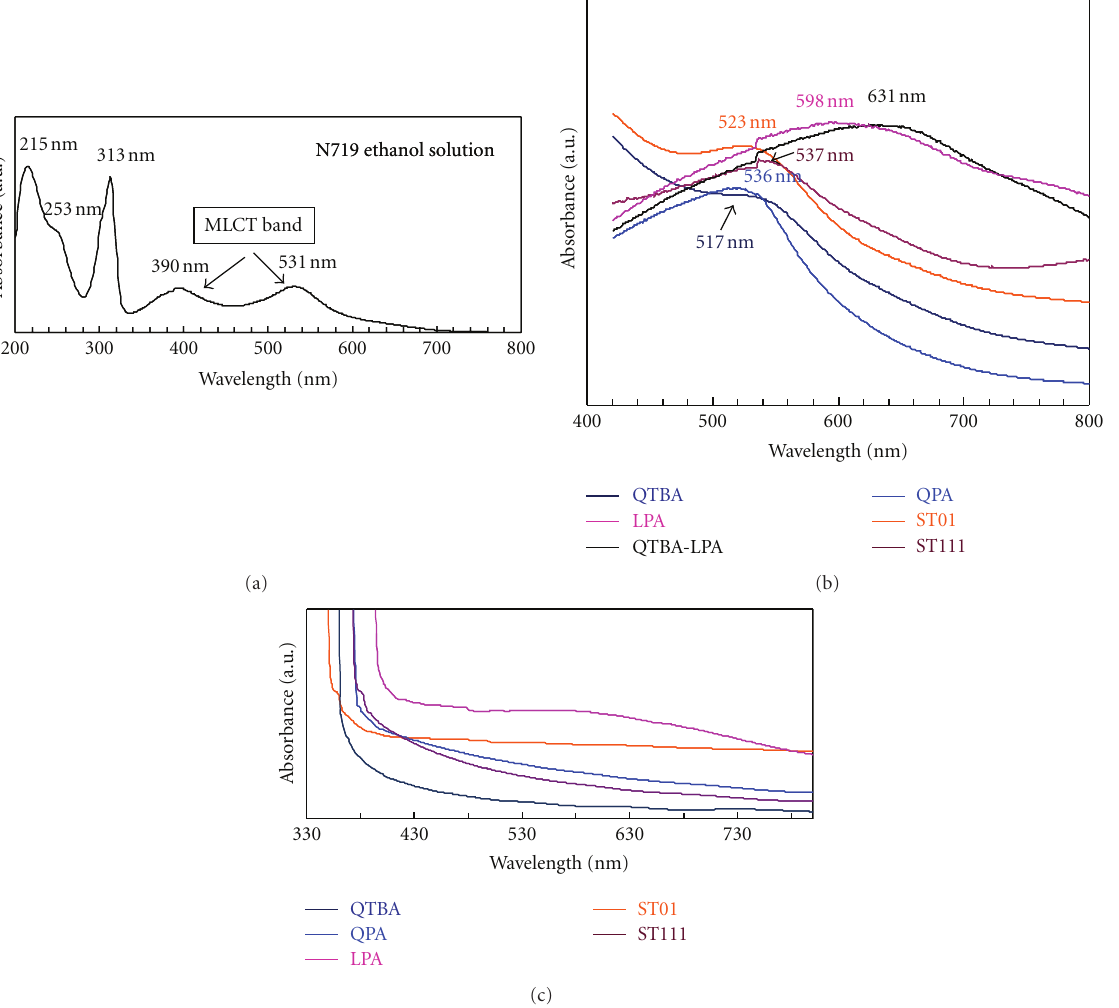
Figure 4: Absorption spectra of N719 dye in ethanol solution (a) and adsorbed onto TiO 2 nanocrystal films (b). Absorption spectra of the TiO 2 nanocrystals film samples